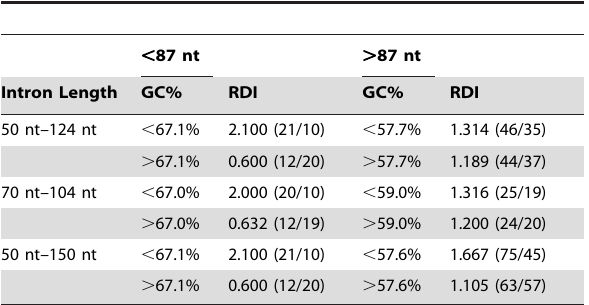
Table 6. RDI (DAF , 0.1) when examining dependence of size- effect on GC